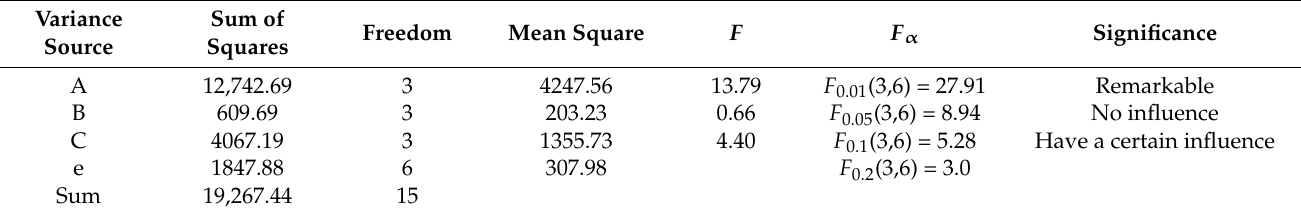
Table 5. Analysis of variance and F test.